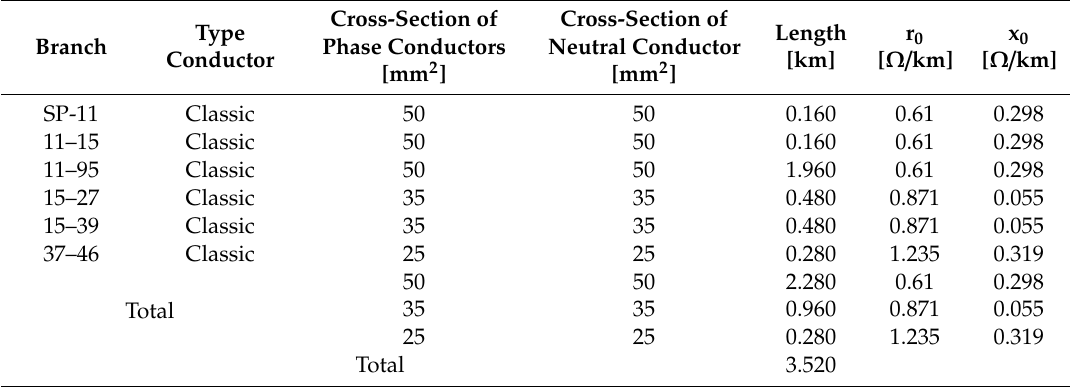
Table 4. The technical characteristics of the branches.